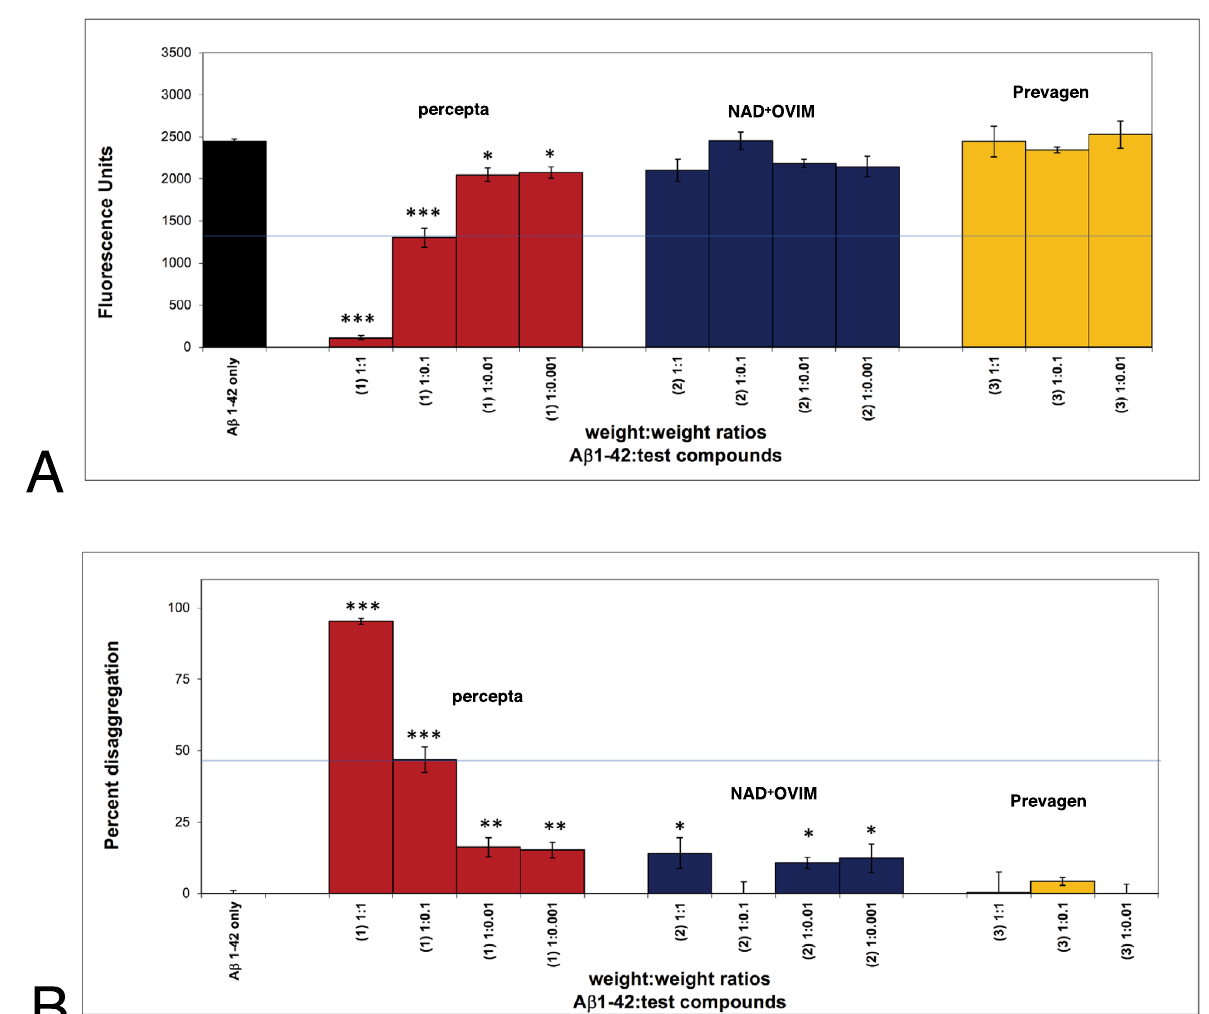
Figure 4. Percepta outperformed NAD + OVIM for disaggregation/disruption of pre-formed Aβ 1–42 fibrils. ( A ) Percepta was tested in comparison to NAD + OVIM and Prevagen supplements on a wt/wt basis. Percepta was the most potent disrupter of Aβ 1–42 fibrils in comparison to NAD + OVIM and Prevagen on a wt/wt basis as quantitatively determined by Thioflavin T fluorometry. Aβ 1–42 fibrils demonstrate binding to Thioflavin T and 2,450 fluorescence units. Percepta demonstrated the most robust disaggregation/dissolution of pre-formed